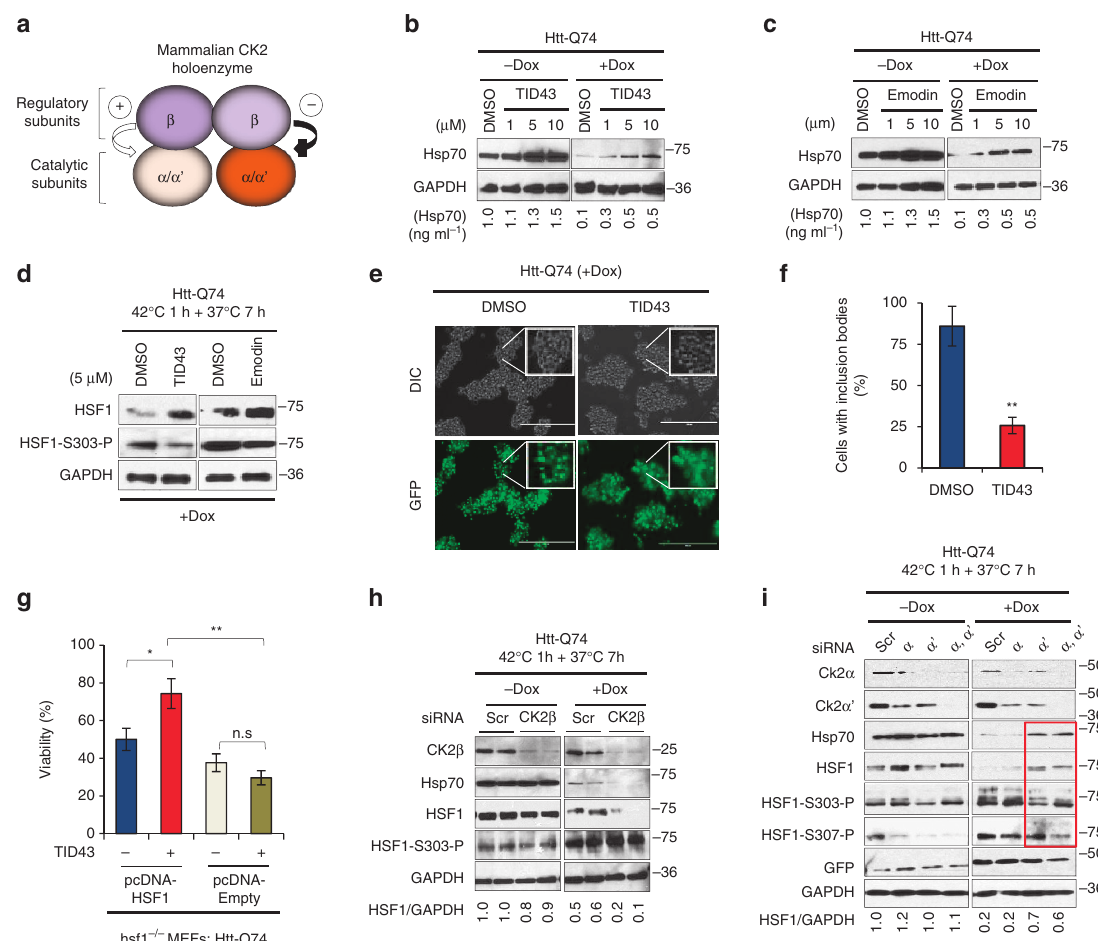
Figure 4 | Mammalian CK2 inhibition ameliorates HSF1 degradation and mHtt aggregation and death in a cellular HD model. ( a ) Mammalian CK2 holoenzyme subunit composition and function. ( b ) Htt-Q74 cells treated with CK2 kinase inhibitors TID43 or ( c ) Emodin 24h before Htt-Q74 induction with Dox and heat shocked at 42 (cid:2) C for 1h followed by recovery at 37 (cid:2) C for 7h and extracts analysed by immunoblotting for Hsp70 and GAPDH. ( d ) Htt-Q74 cells treated with 5 m M TID43 and immunoblotted for HSF1 and P-HSF1-S303. ( e ) Fluorescent images for GFP-Htt-Q74 analysed microscopically in cells treated with DMSO or 1 m M TID43 as described in B. Scale bar: 200 m m. ( f ) Quantification of cells containing GFP-Htt-Q74 aggregates from E expressed as percentage of total number of cells evaluated. Error bars represent ± s.e.m., ( n ¼ 500 cells). Unpaired t -test ** P o 0.05. ( g ) hsf1 (cid:2) / (cid:2) MEFs expressing Dox-inducible Htt-Q74-GFP transfected with pcDNA or WT HSF1 and incubated with 1 m M TID43 24h before Htt-Q74-GFP induction followed by heat shock at 42 (cid:2) C during 1 and 7h recovery at 37 (cid:2) C. Cell viability expressed as % of viable cells under control conditions at 37 (cid:2) C. Error bars represent ± s.e.m., ( n ¼ 3). Unpaired t -test n.s., no significant, * P o 0.05, ** P o 0.01). ( h ) Htt-Q74 cells were transfected with siRNA against CK2 b regulatory subunit or ( i ) CK2 a and/or CK2 a 0 catalytic subunits using scrambled siRNA (Scr) as control 24h before Htt-Q74 induction during 2 days followed by heat shock at 42 (cid:2) C 1h and recovery at 37 (cid:2) C, 7h. HSF1 was quantitated as in (F2H). All immunoblots shown for each panel contain the samples from the same membrane and were cropped to show only relevant data. See Supplementary Fig. 10 for uncropped immunoblots. mitochondrial biogenesis and energy metabolism 47 . Both PGC-1 a exhibited higher HSF1 protein levels and Hsp70 expression compared to CK2 a 0 þ / þ littermates, suggesting a physiological and its target genes, CYCS (cytochrome c ), TFAM (mitochondrial role for CK2 in regulating HSF1 abundance and activity transcription factor) and NDUFS3 (NADH dehydrogenase) are (Supplementary Fig. 6A). Given the dramatic elevation in CK2 a 0 reduced in the striatum of the N171-82Q HD mouse model and levels in HD models and patients, mice heterozygous for CK2 a 0 in human patients, in part underlying the mitochondrial (CK2 a 0 þ / (cid:2) ) were generated in the KIQ175 background to evaluate the impact on HSF1 levels, activity and on the neuro- showed elevated expression of PGC-1 a and target genes pathology observed in this HD model (Fig. 7a and Supplementary compared to KIQ175 littermates (Fig. 7d and Supplementary Fig. 6B). KIQ175/CK2 a 0 þ / (cid:2) mice exhibited B 2.5-fold decreased Fig. 6E). Importantly, HSF1 and Hsp70 protein levels were increased, mutant Htt aggregates decreased and soluble mutant CK2 a 0 , and B 1.5-fold increased CK2 a striatal mRNA levels and WT Htt protein increased in the striatum of KIQ175/ compared to KIQ175 littermates (Fig. 7b and Supplementary CK2 a 0 þ / (cid:2) mice compared to KI175 littermates (Fig. 7e,f; Fig. 6C). Heterozygosity of CK2 a 0 increased expression of the HSF1 targets Hsp70 and Hsp25 (Fig. 7c and Supplementary Supplementary Fig. 6F,G). Fig. 6D). CK2 a 0 reduction preserves MSNs and muscle mass . Previous The co-activator peroxisome proliferator-activated receptor gamma (PGC-1 a ) is an HSF1 target that is a key regulator of studies demonstrated decreased abundance of dendritic spines NATURE COMMUNICATIONS|8:14405|DOI: